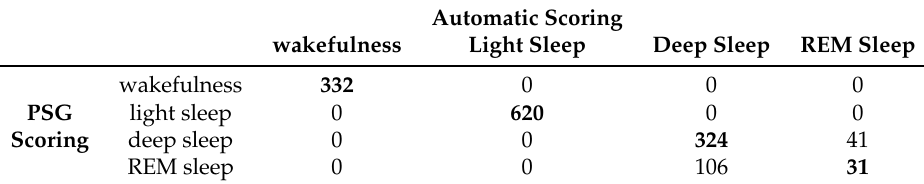
Table 6. Confusion matrix for patients with